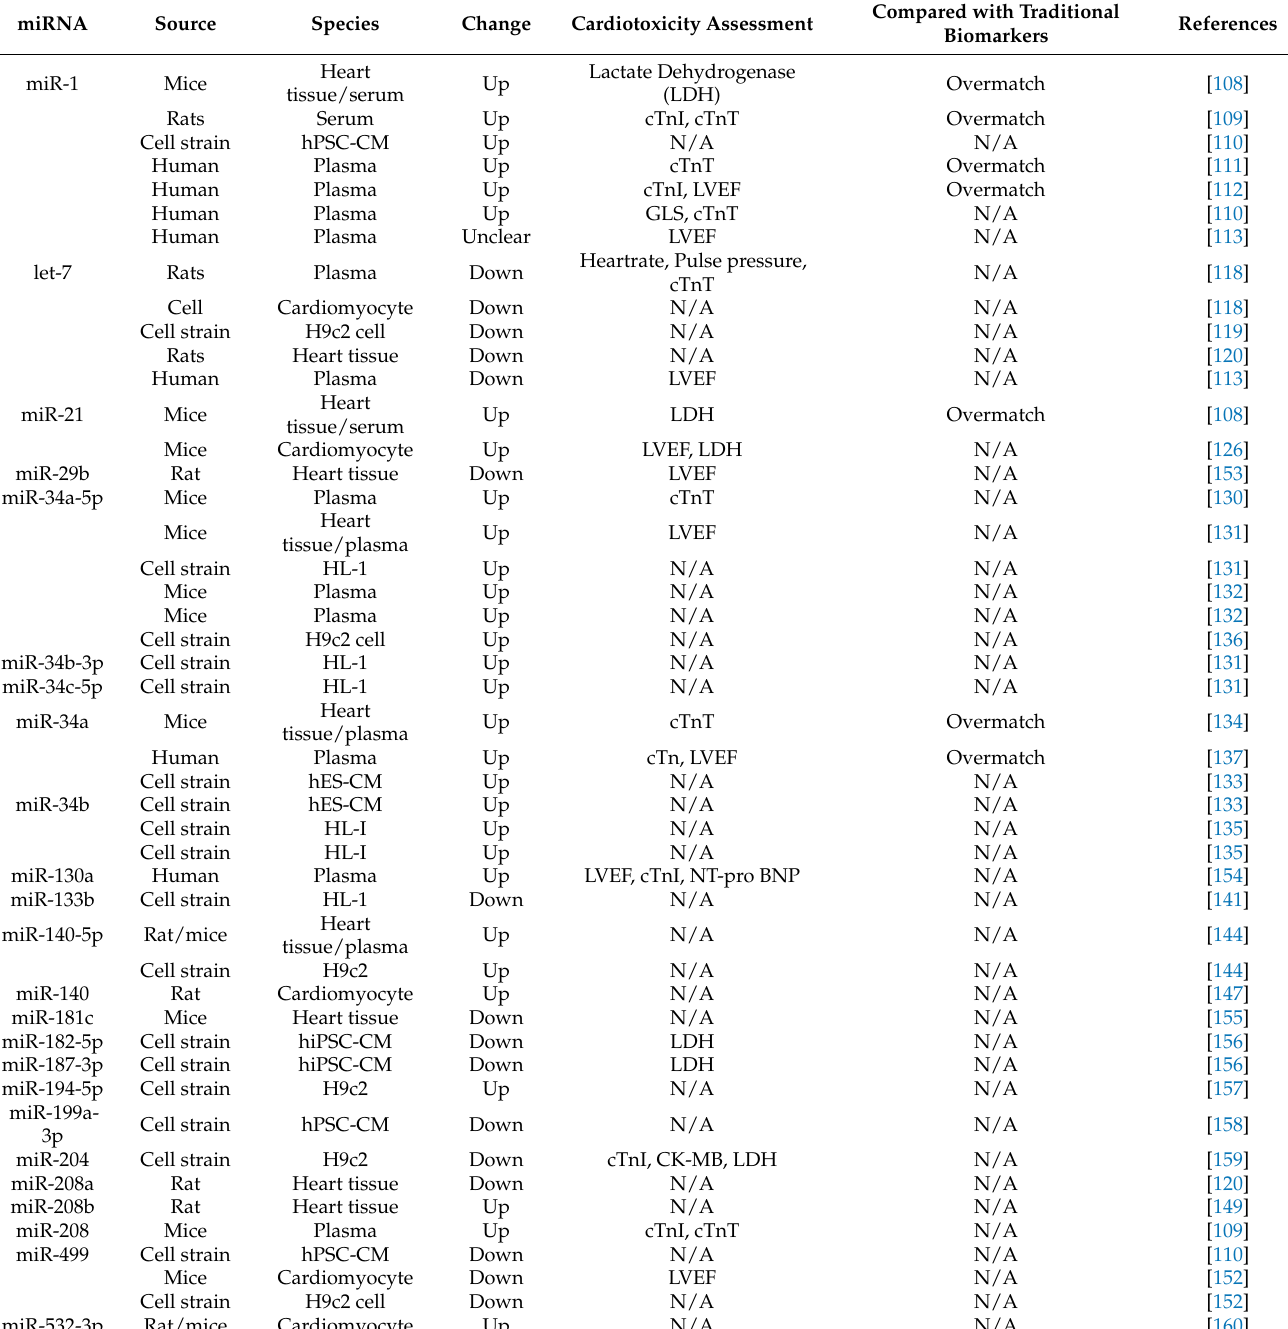
Table 1. Expression of miRNAs as biomarkers in